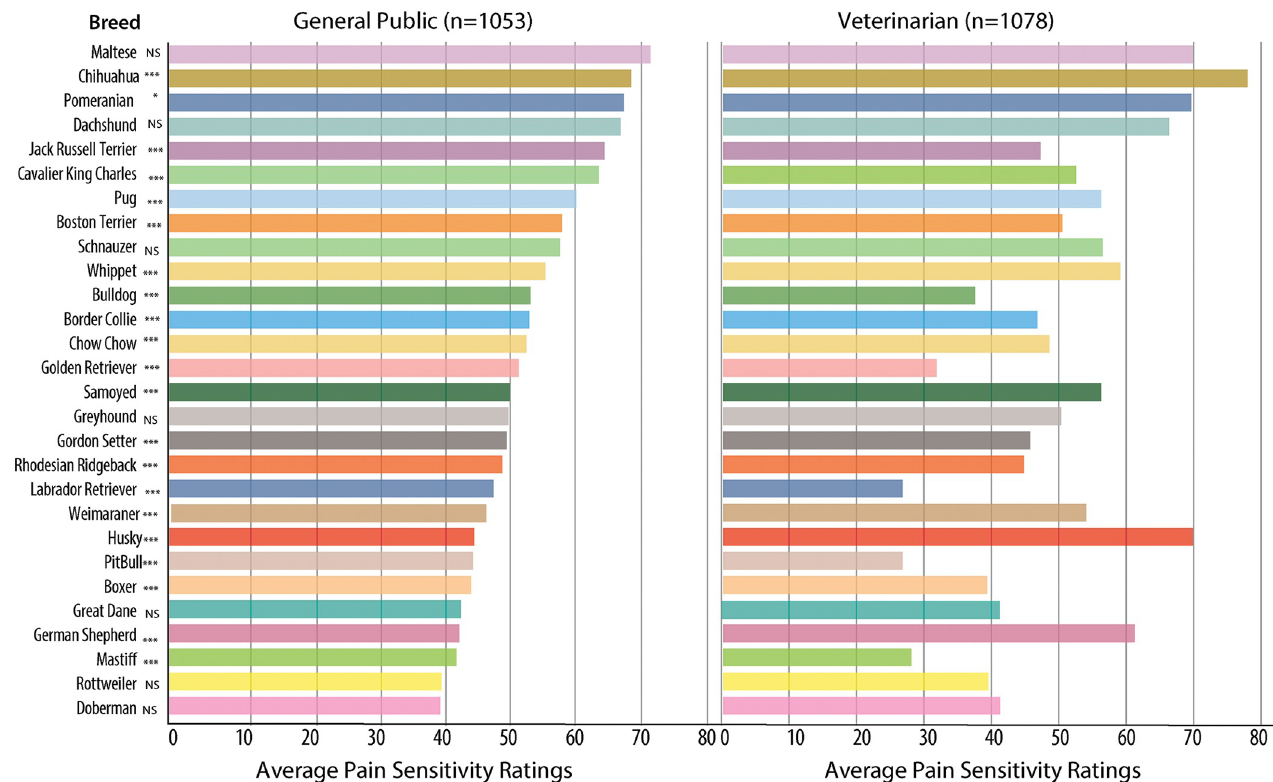
Fig 1. Average pain sensitivity ratings for each dog breed, shown separately for the general public and veterinarian respondents. The scale ranged from 0 = not at all sensitive to 100 = most sensitive imaginable. Median pain sensitivity ratings between the veterinarians and general public were compared using two-sample t-tests. p-values are ��� = 0.001, � = 0.05.